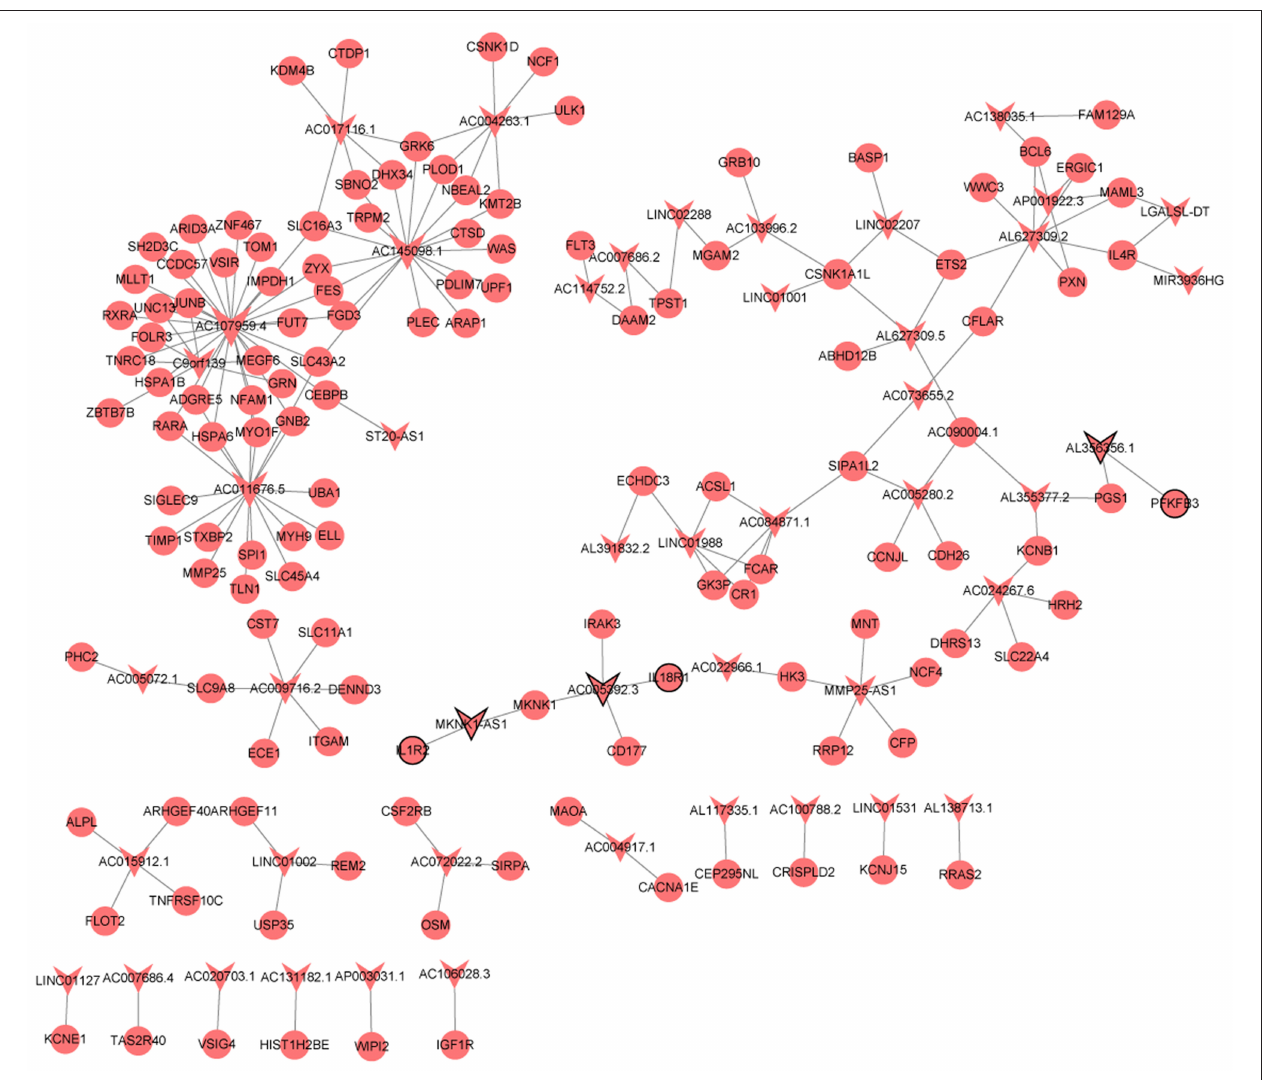
FIGURE 4 | The interaction network of common lncRNA-co-expressed mRNA pairs between MF vs. AMI and HF vs. MF. The arrow and circle represent lncRNA and co-expressed mRNA, respectively. Arrow/circle with a black border represents core